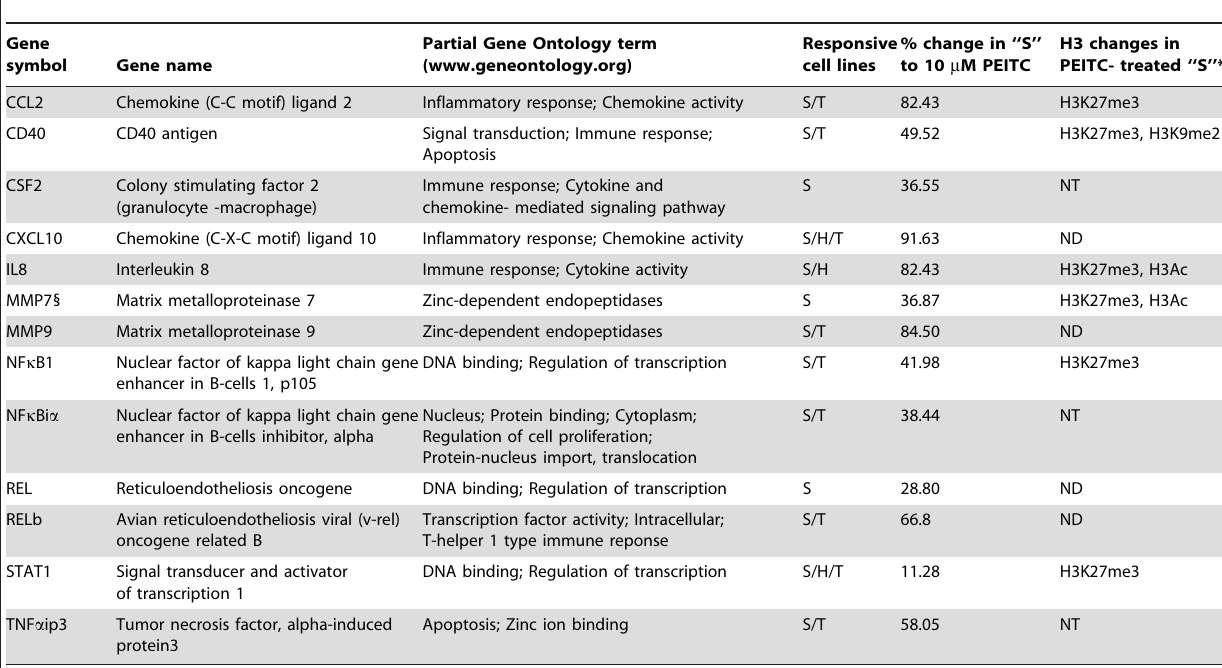
Table 3. Genes down-regulated ( $ 3-fold vs LPS activation alone) by PEITC in various human cells.